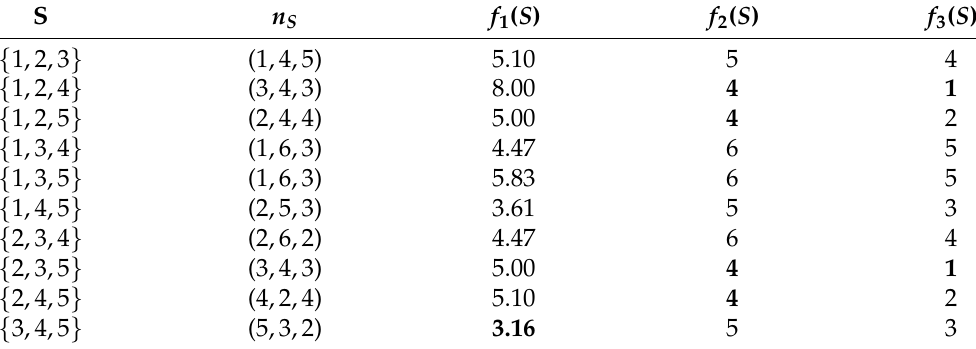
Table 2. All feasible